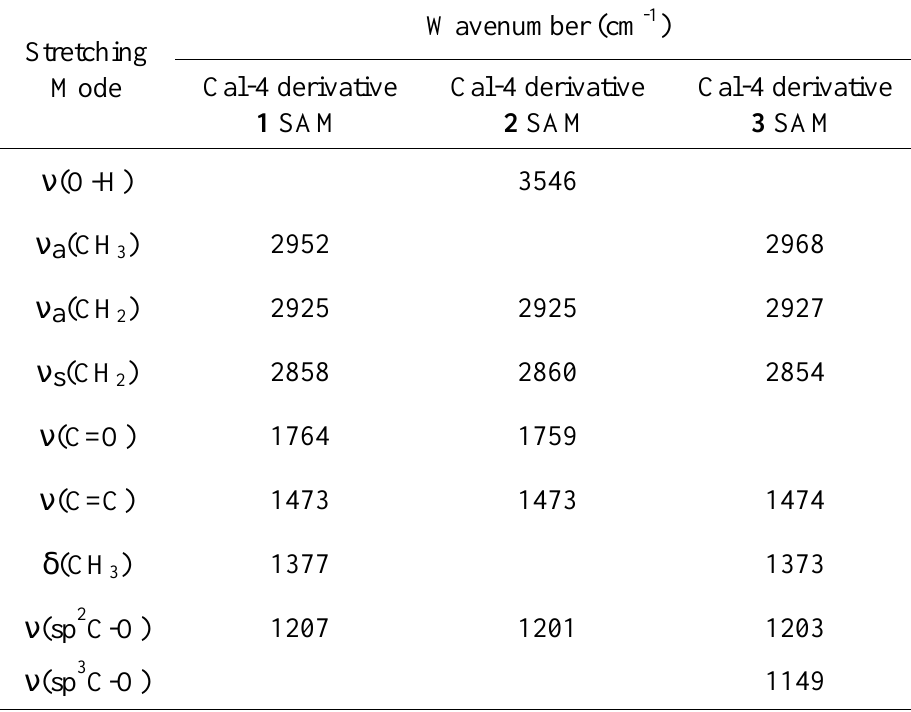
Figure 4 . SPR angle shifts according to the immobilization of Cal-4 derivative SAMs. (a) Cal-4 derivative 1 and 2 SAMs, (b) Cal-4 derivative 3 SAM. Table 1 . FTIR-RAS spectra assignment of Cal-4 derivative